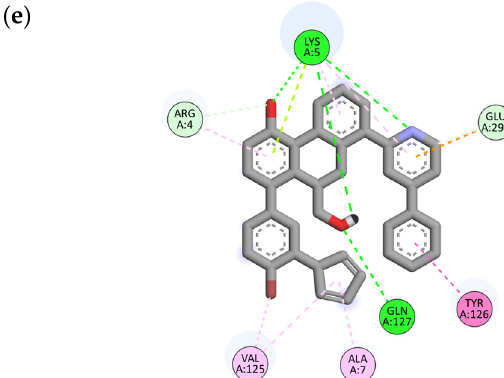
Figure 5. 3D representation of superimposition of the binding poses within the DIS of SARS-CoV-2 of 49 , 49n , 49p , and 49x molecules in white, cyan, magenta and blue color respectively ( a ); 2D representation of interactions within the DIS of SARS-CoV-2 Mpro of 49 ( b ), 49n ( c ), 49p ( d ), and 49x ( e ) molecules.